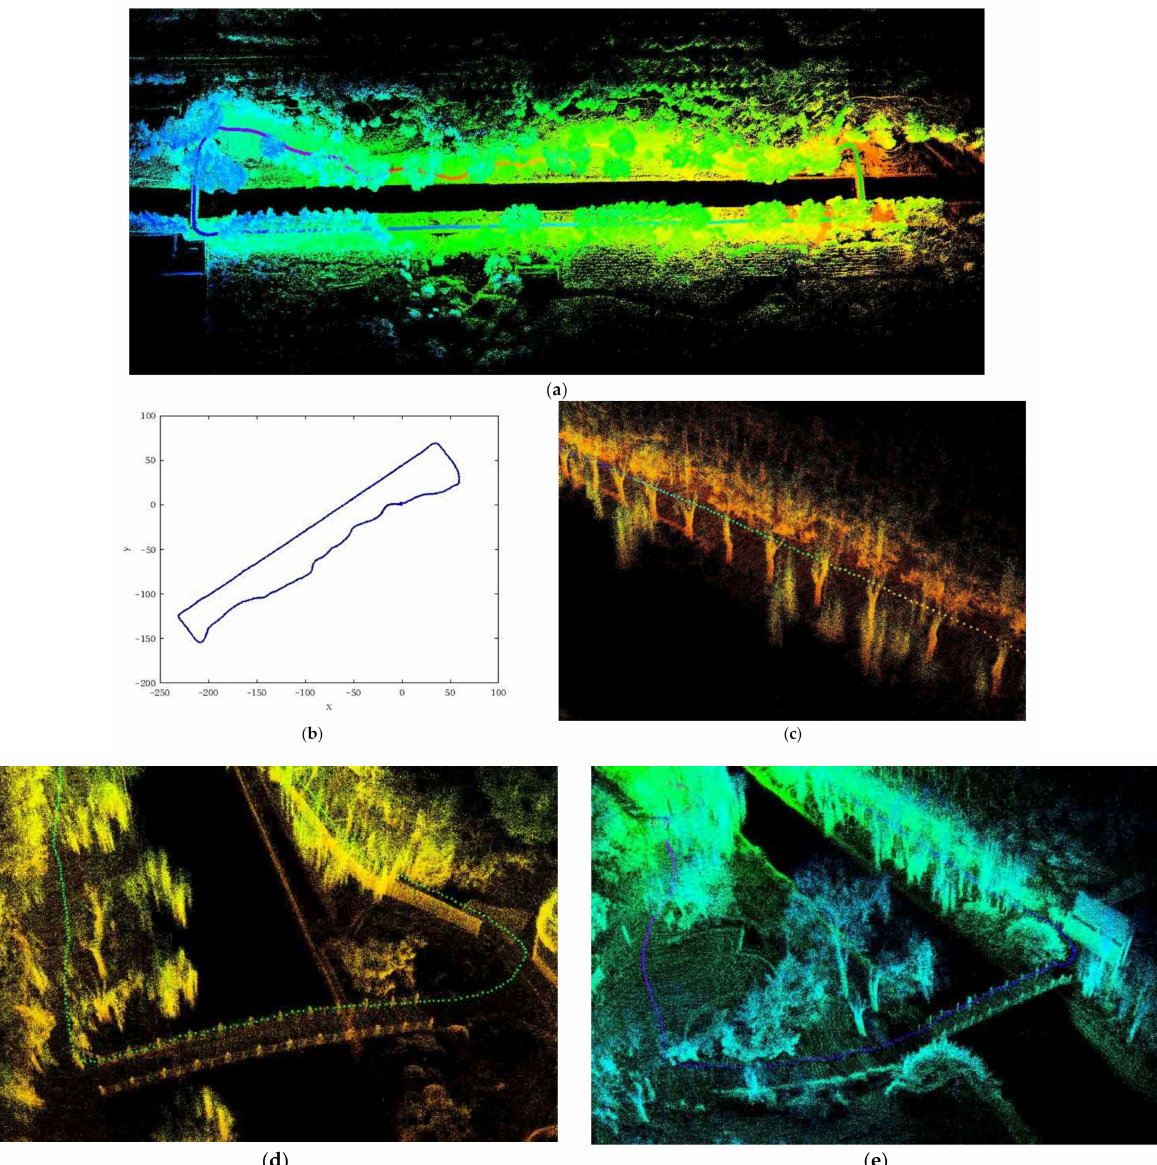
Figure 10. The 3D point cloud map of Yuandu Heritage Park. The ASQWolf system started from the arch bridge ( d ) via the sections of ( c ) and ( e ), and finally returned to the arch bridge ( d ); ( a ) is the 3D point cloud map and ( b ) is the trajectory of the ASQWolf